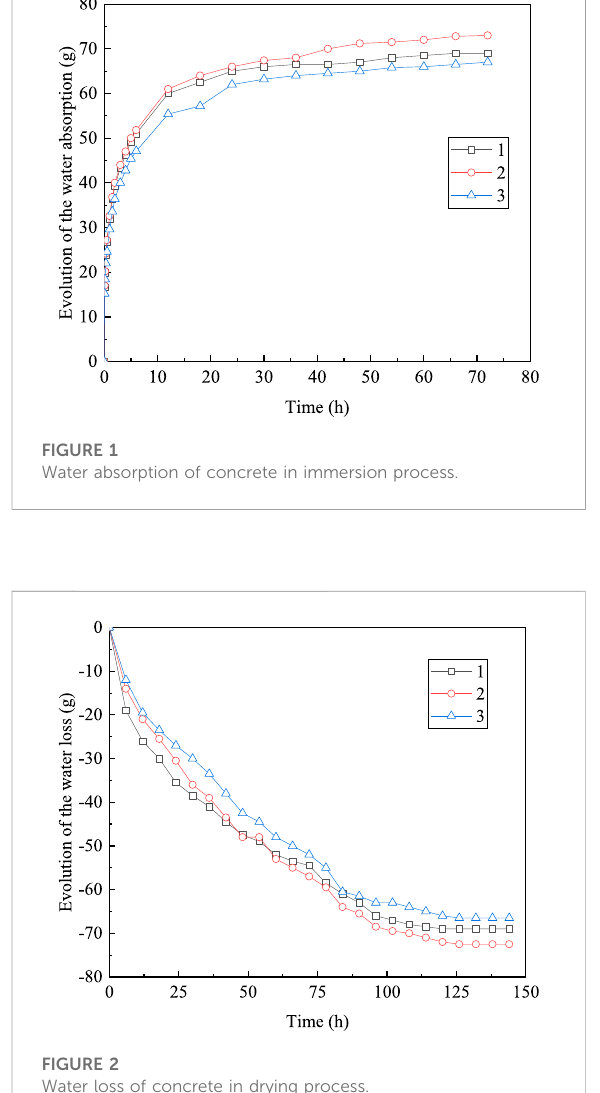
FIGURE 2 Water loss of concrete in drying process.